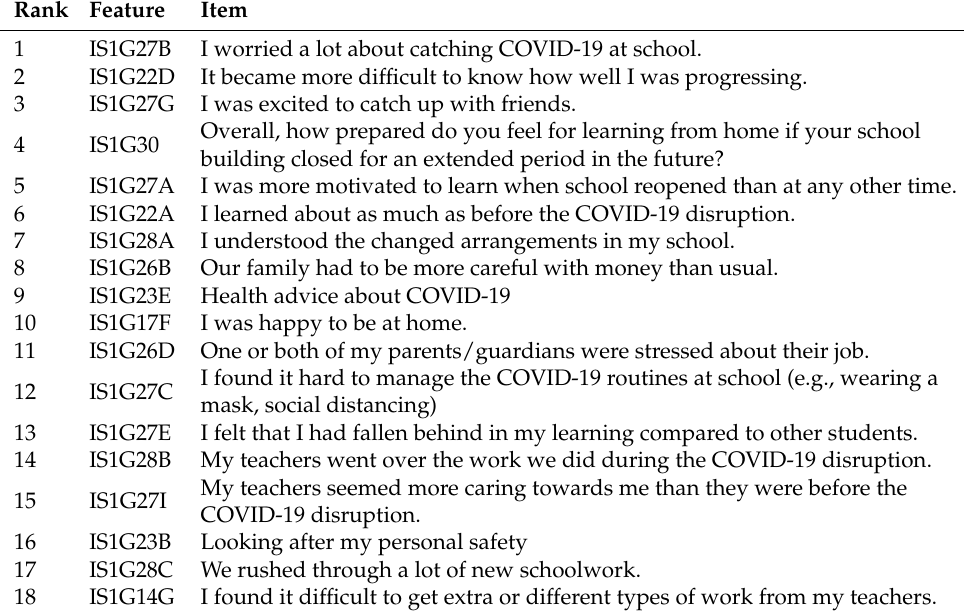
Table 4. Top 10% most influential variables for the DM dataset.